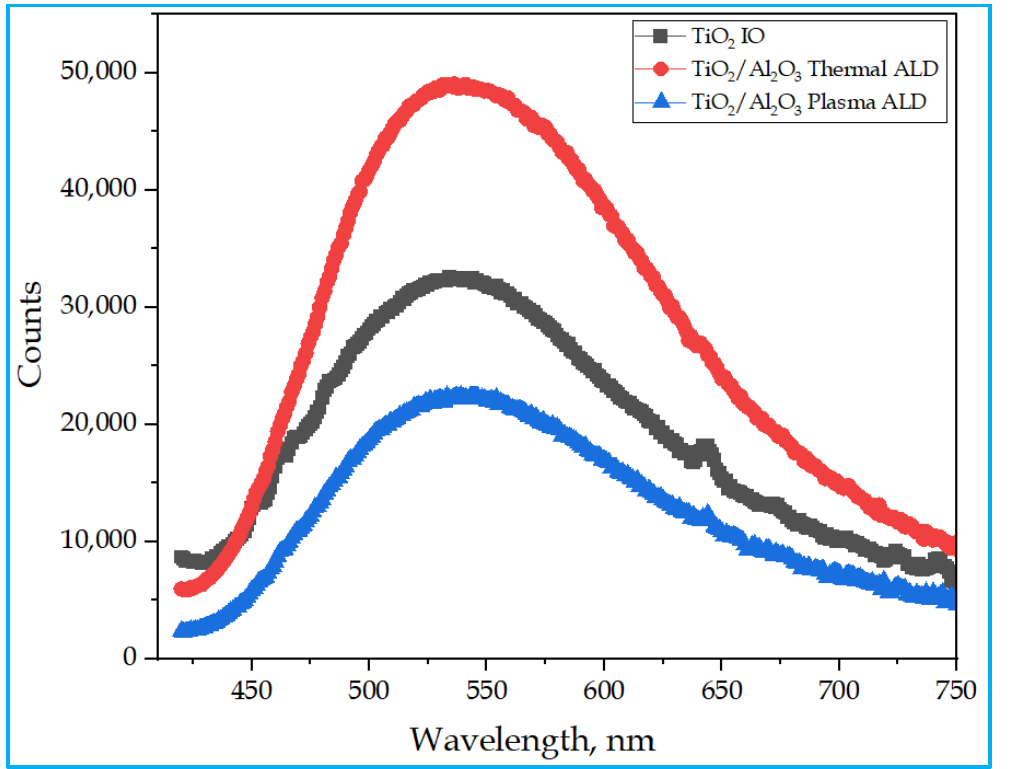
Figure 6. PL spectra of the samples .